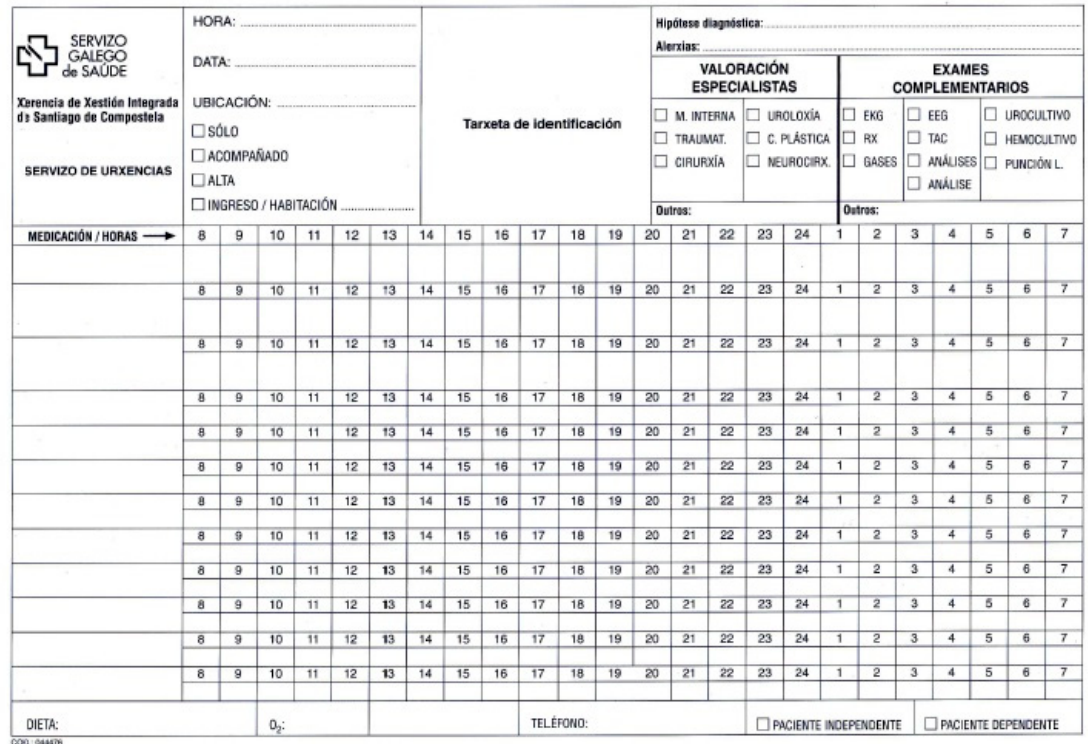
Figure 1. Medication administration record and complementary medical